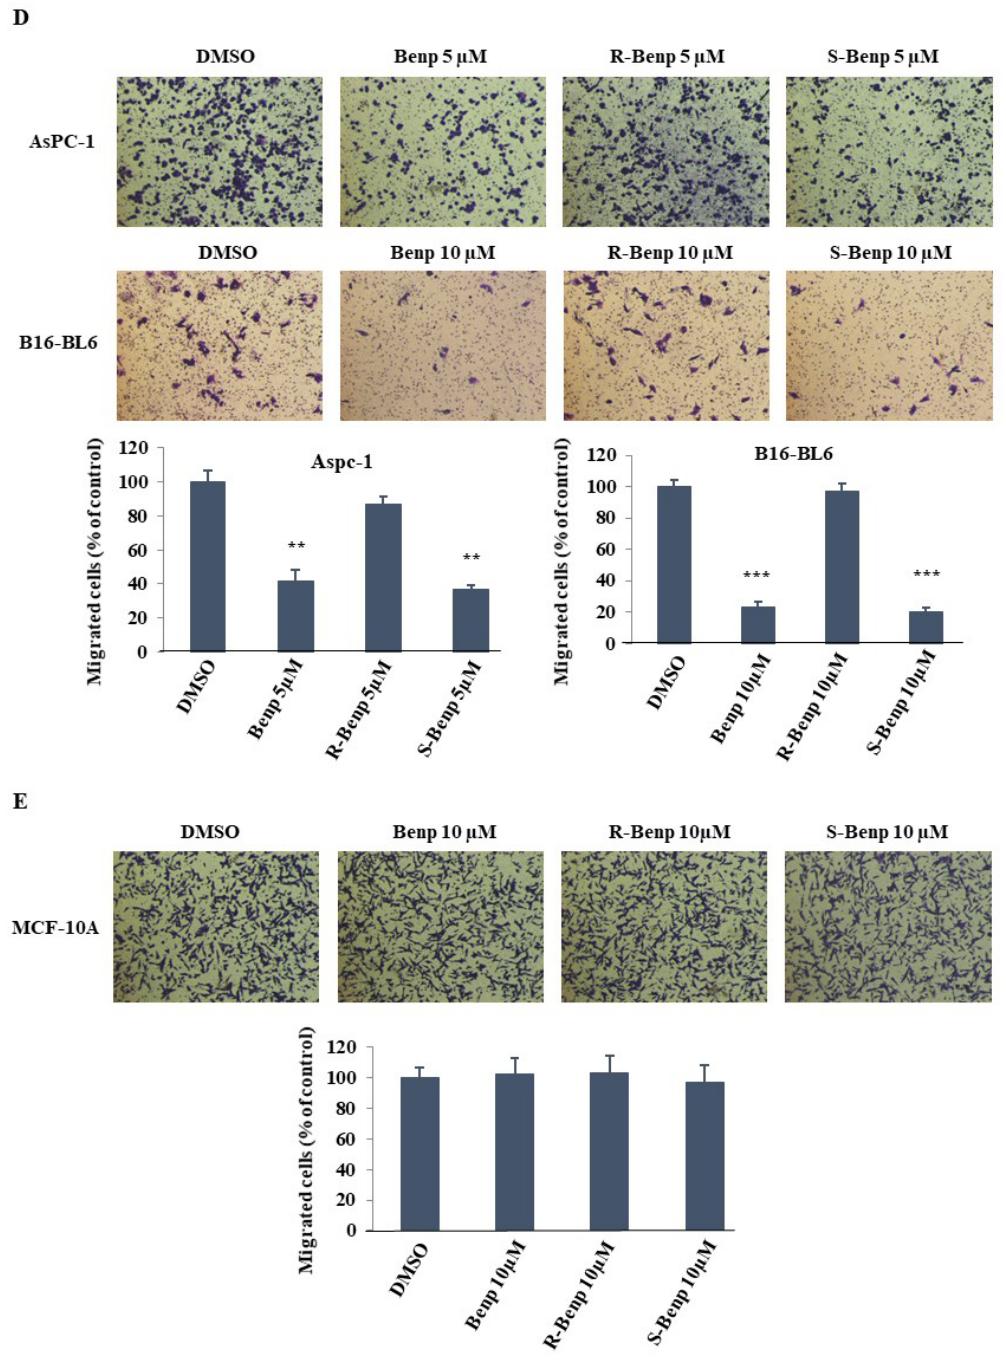
Figure 1. Inhibition of cancer cell migration by stereoisomers of benproperine. ( A ) Structure of isomeric benproperine (Benp). ( B ) Cytotoxic effect of R- and S-Benp. After treatment with R- or S-Benp for 24 h, DLD-1 live cells were measured via a WST-1 assay. ( C ) Migration inhibitory effect of Benp isomers in DLD-1 cells. ( D ) Migration inhibitory effect of Benp isomers in AsPC-1 and B16-BL6 cells. ( E ) Migration inhibitory effect of Benp isomers in MCF-10A cells. Migrated cells were detected via a Transwell migration system and visualized through crystal violet staining. The data represent means ± s.d.; comparisons were performed with t tests (two groups); * p < 0.05, ** p < 0.01, *** p < 0.001.